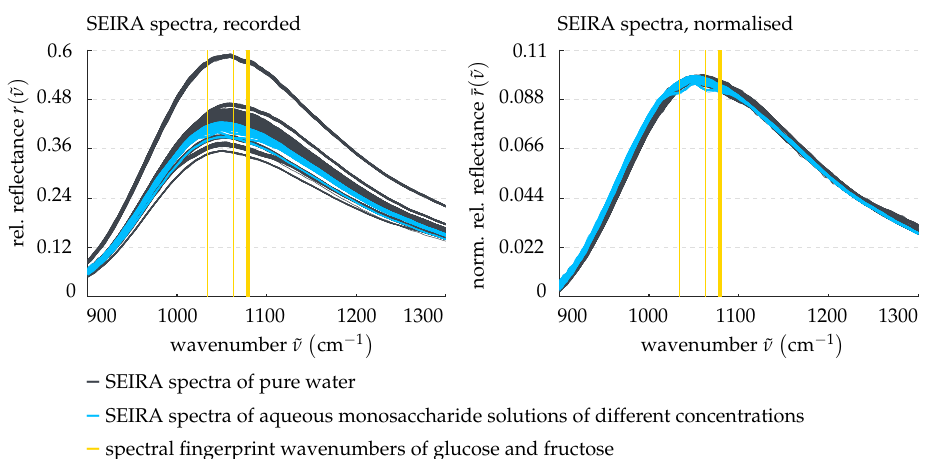
Figure 5. Pre-processing step 1: normalisation of the recorded SEIRA spectroscopy sensor data. ( Left panel ) raw measured spectra. ( Right panel ) spectra normalised with respect to the Euclidean